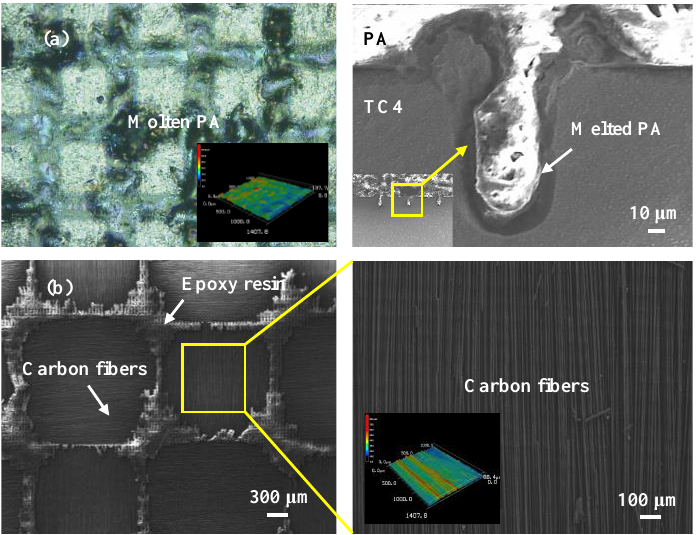
Figure 7. ( a ) Surface morphology of TC4 alloy after laser plastic-covered treatment; ( b ) surface morphology of CFRTS after laser cleaning. Table 4. Measurement dimensions of micro-textures at different scanning spacings.